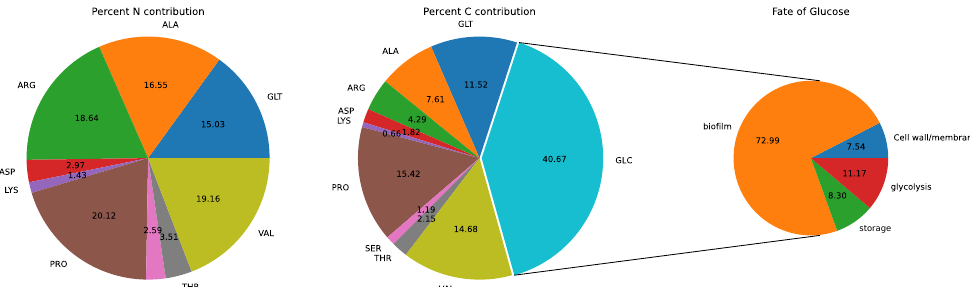
Figure 2. Percentage C and N contribution from the excess importation of amino acids in Figure 1. Among amino acids, proline, valine, alanine, glutamate and arginine are the major contributors in C and N. Although Glucose is the major contributor to C, only ≈ 10% enters glycolysis, while the remainder is utilised for the biofilm, storage and structural components of the